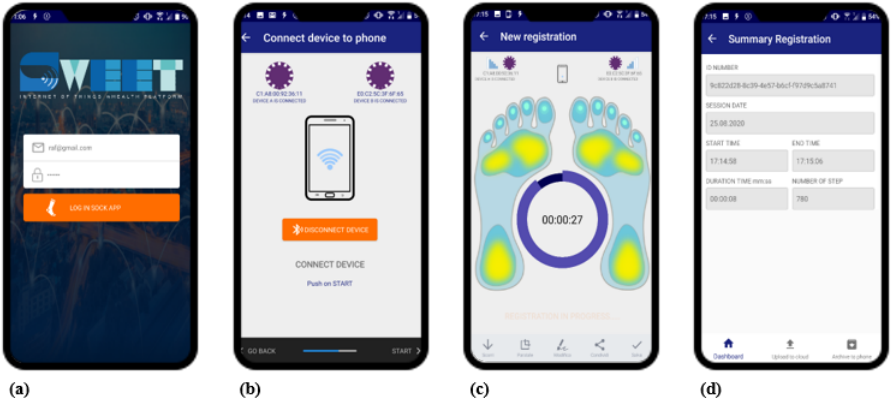
Figure 4. SWEET App main frames: ( a ) login; ( b ) unit connection; ( c ) signal recording; ( d ) results